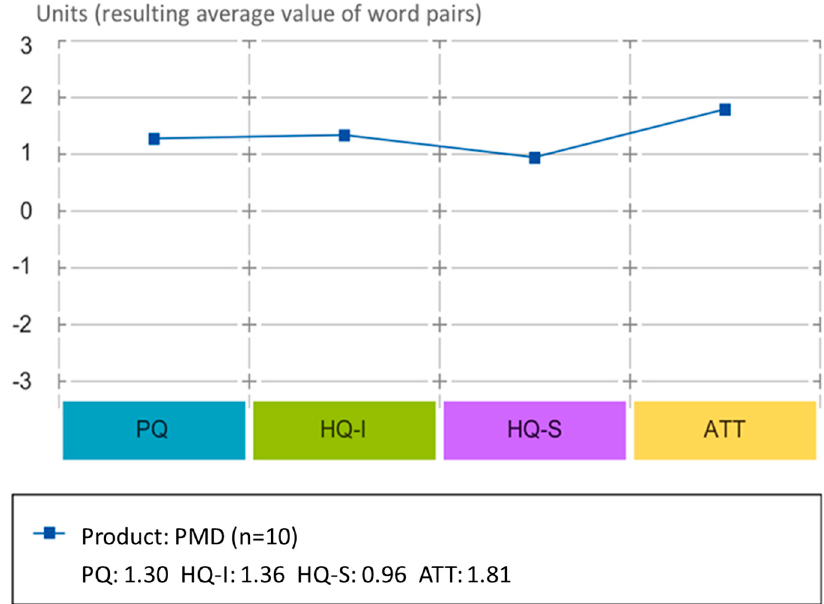
Figure 5. Diagram of the average values for pragmatic qualities (PQs), hedonic identity quality (HQ-I), hedonic stimulation quality (HQ-S), and attractiveness (ATT) for the study 3.2.2.